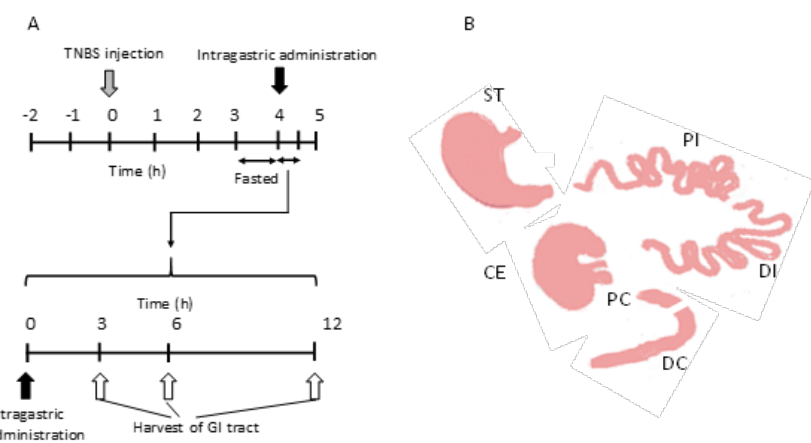
Figure 7. Animal experiment procedure of drug distribution in the gastrointestinal tract of UC model rats. ( A ) After fasting for 48 h, TNBS was injected from the anus, and 3 days later, rats that lost 20% of their body weight were fasted for another 24 h, subjected to intragastric dosing, and sacrificed after 3, 6, and 12 h. ( B ) Diagram of the division of the gastrointestinal tract. ST, stomach; PI, proximal small intestine; DI, distal small intestine; and CE, cecum; PC, proximal colon; DC, DC. The length of PI = the length of DI; The length of DC = 2 × the length of PC.